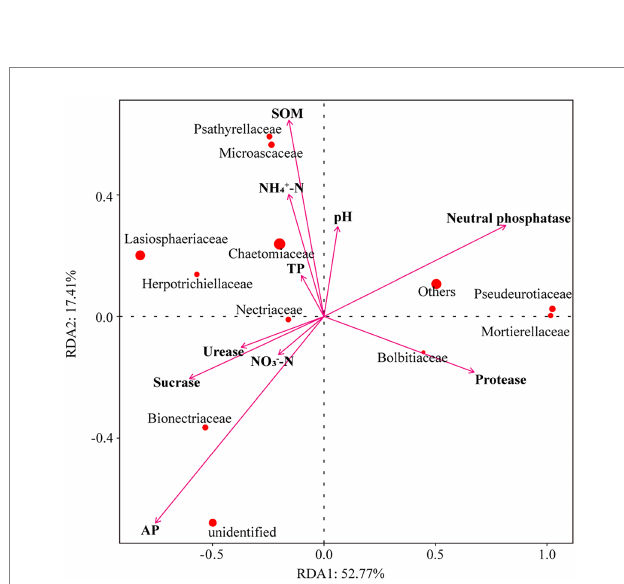
FIGURE 6 Redundancy analysis (RDA) of fungal families constrained by soil environmental factors across all experimental units. The arrows refer to soil environmental factors. The red circle represents fungal families, and the circle size represents relative